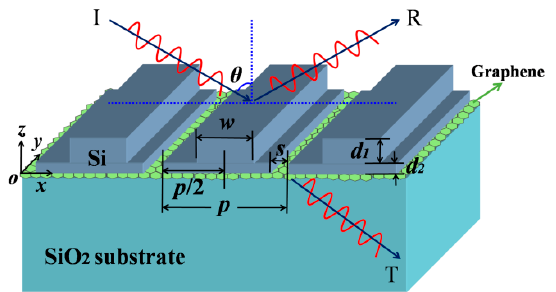
Figure 1. Schematic diagram of a subwavelength Si-based photonic crystal slab (PCS) with a monolayer graphene at the incident angle of θ . The monolayer graphene is sandwiched between the Si PCS and the SiO 2 substrate, the structural symmetry of the PCS is broken due to the slit in the sublayer. d 1 and d 2 stand for the thickness of the grating layer and the sublayer, respectively. The width of the grating layer is w , and the width of the slit in the sublayer is s ; the period is p . In the Vis–NIR region, graphene can be modeled as an ultrathin dielectric film with thickness of t g = 0.34 nm, and its relative permittivity can be written as ε g = 1 + j σ g / ωε 0 t g